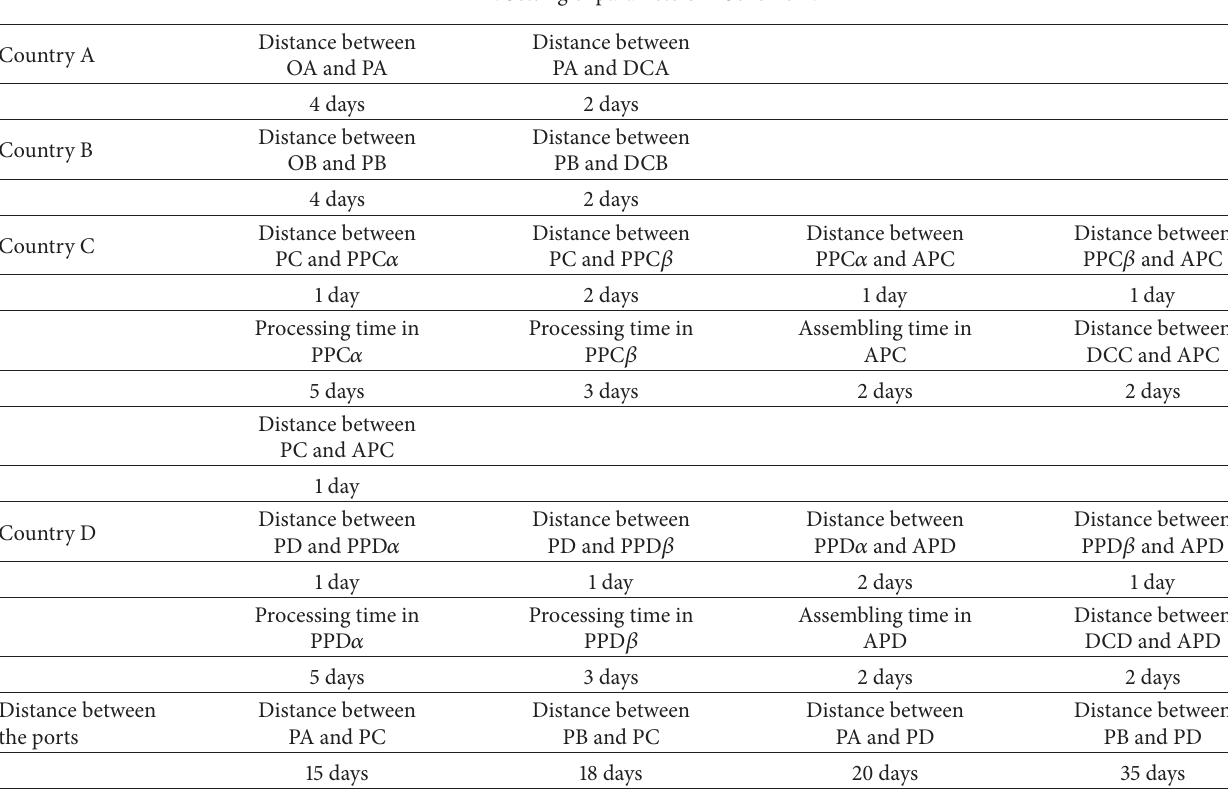
Table 12: Setting of parameters in Scheme 4.